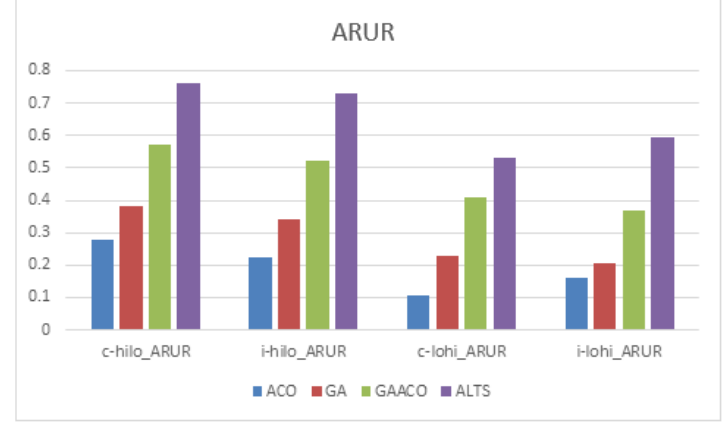
Figure 5. ARUR comparison.